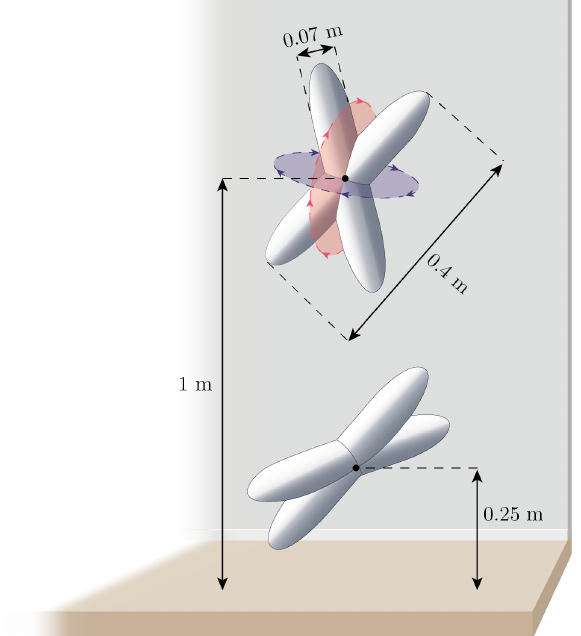
Figure 7. Illustration of spinning objects used to trigger the motion sensors in Study